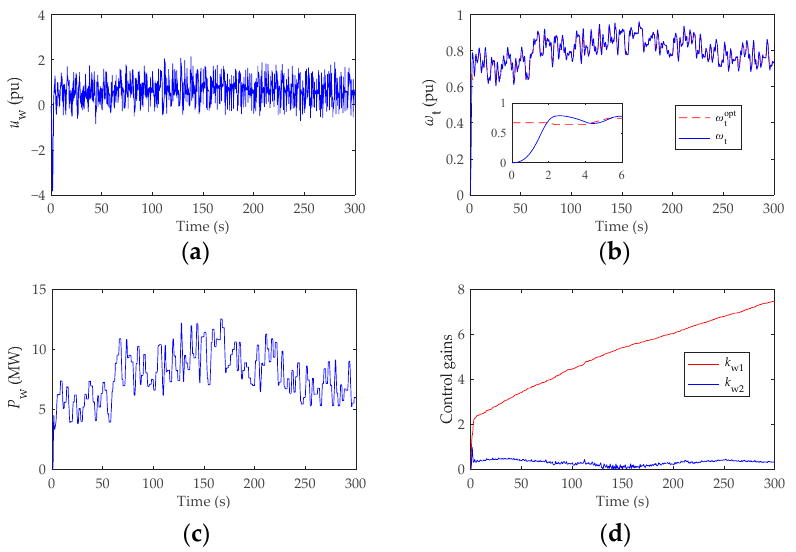
Figure 10. Results of wind power system ( a ) Control input u w . ( b ) Tracking of the rotating speed ω t . ( c ) Power output P w . ( d ) Control gains k w 1 and k w 2 .